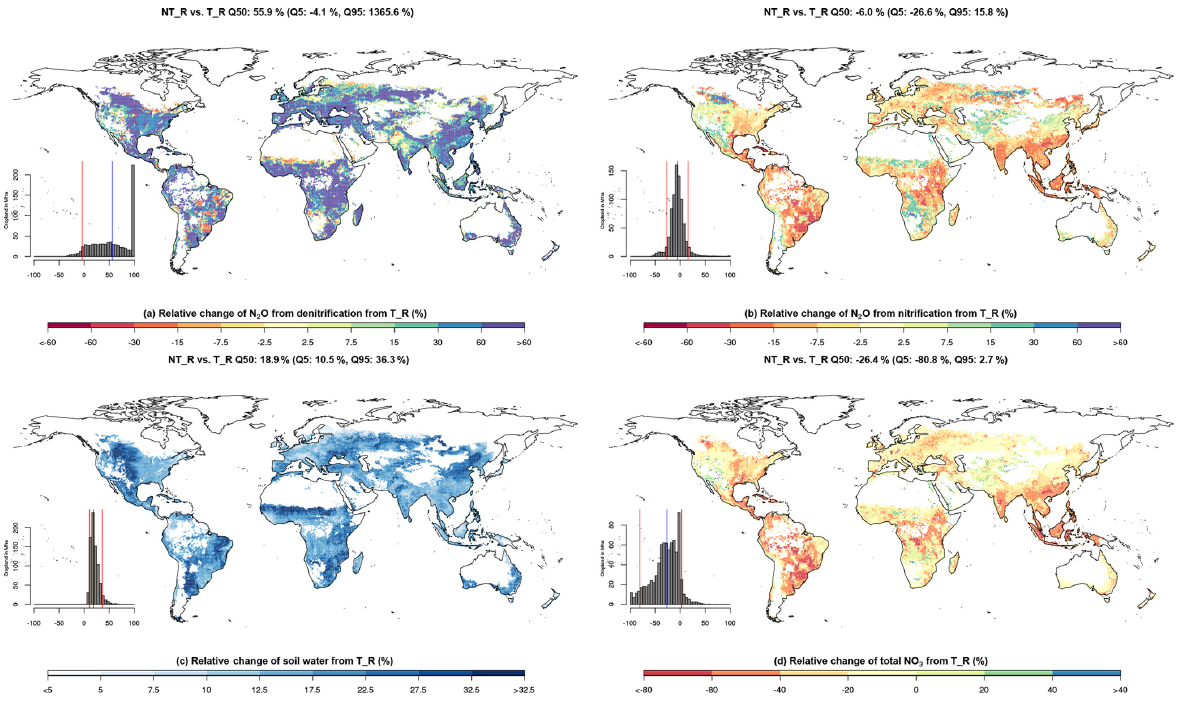
Figure 5. Relative changes for the average of the first 3 years of NT_R vs. T_R for denitrification (a) , nitrification (b) , soil water content (c) , (d) and NO − 3